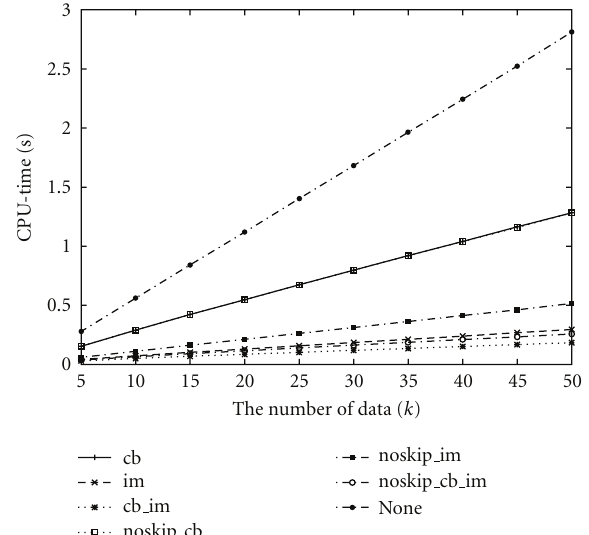
Figure 11: CPU time on 11-dimensional data.